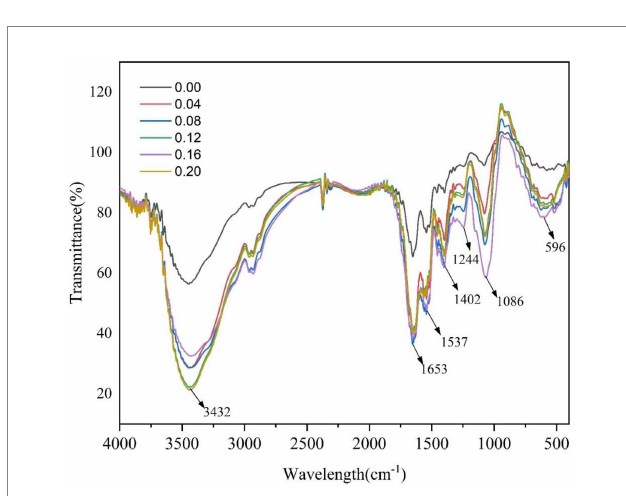
FIGURE 7 Effect of xanthan gum content on secondary structure of protein powder.